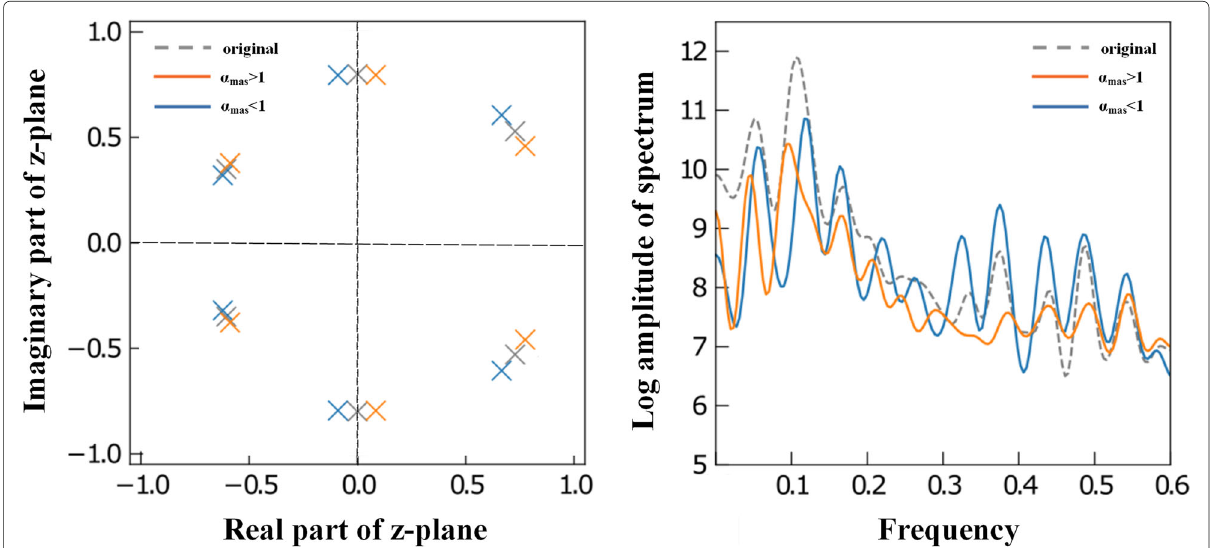
Fig. 4 Examples of McAdams transformation: transformed pole shift (left) and spectrogram change after transformation